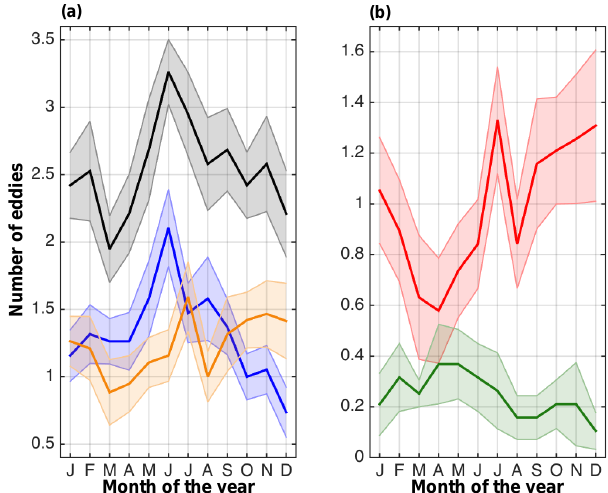
Figure 9. Seasonal cycle of the number of eddies generated in the costal region per year based on the results of the OW method as shown in Figs. 7 and 8. In (a) the seasonal cycle of all eddies is marked by the black line, of cyclones by the blue line and of all anticyclonic eddies by the orange line. In (b) the seasonal cycle of anticyclonic eddies is separated into anticyclones (red line) and ACMEs (green line). The shaded areas around the lines represent the standard